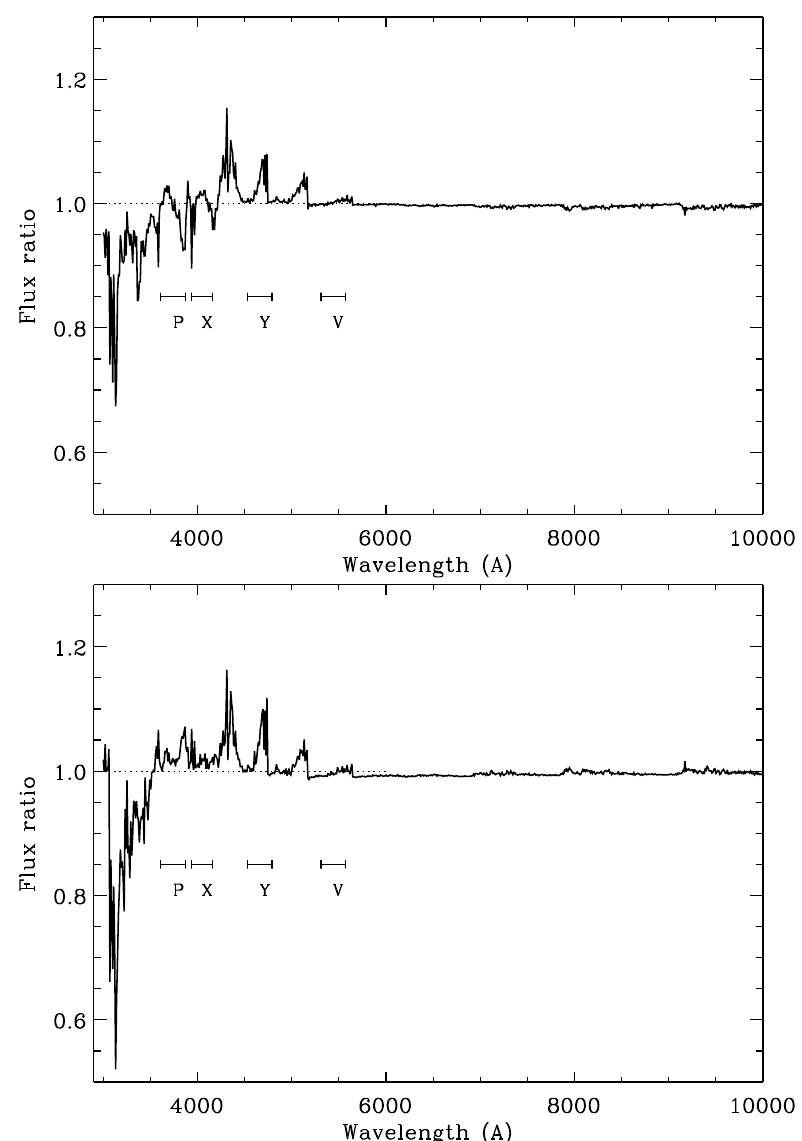
Fig. 1. Sensitivity of the modeled surface energy flux ratios to varia- tions in carbon and nitrogen abundances. The figures show the differential effects on the spectra of coordinated abundance changes of carbon and ni- trogen: Δ [C/Fe] = − 0 . 2 and Δ [N/Fe] = +0 . 3 . In the top-panel the models have T e = 5000 K, log g = 2.5 and [Fe/H] = 0, corresponding to a clump star. In the lower-panel the models have T e = 4250 K, log g = 1.5 and [Fe/H] = 0 which is typical for our